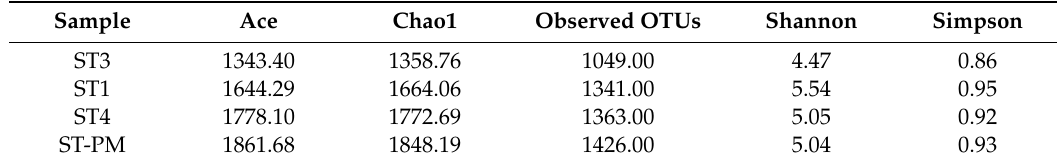
Table 1. Alpha diversity analysis based on 16S rRNA gene data from